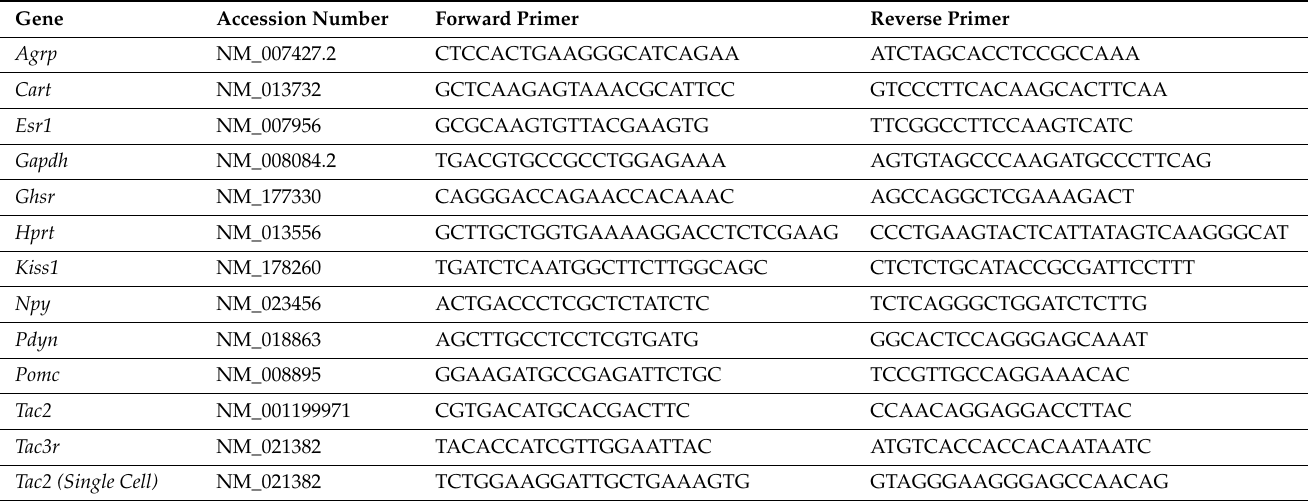
Table 1. List of primers for